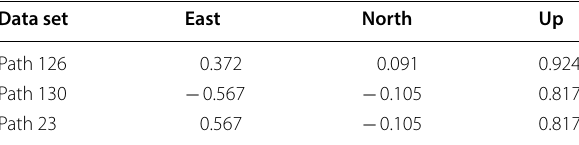
Table 2 LOS vectors of the three data sets at the